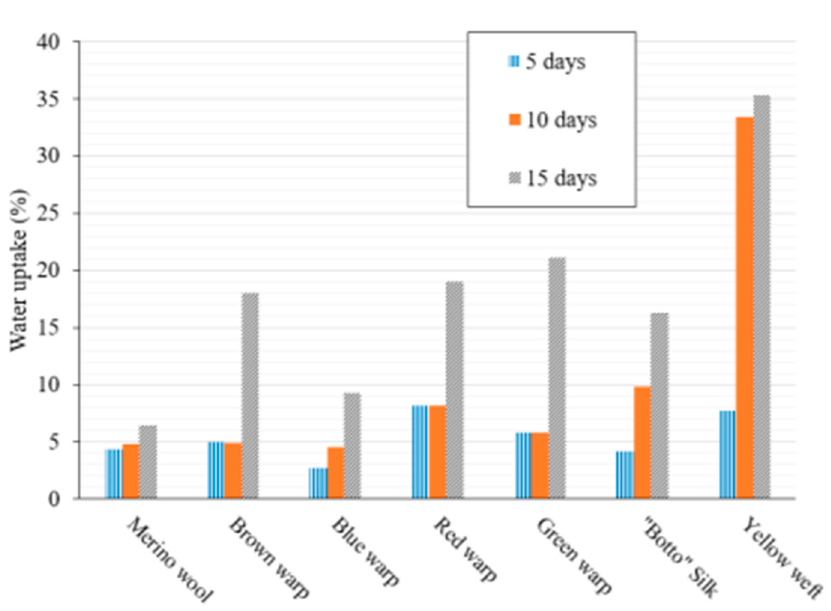
Figure 1. Water uptake values of commercial Merino wool, of “Botto” silk and of the Sixteenth Century yarns (brown, blue, red and green wrap and yellow weft yarns). The results were obtained at 25 °C and relative humidity of 75%.